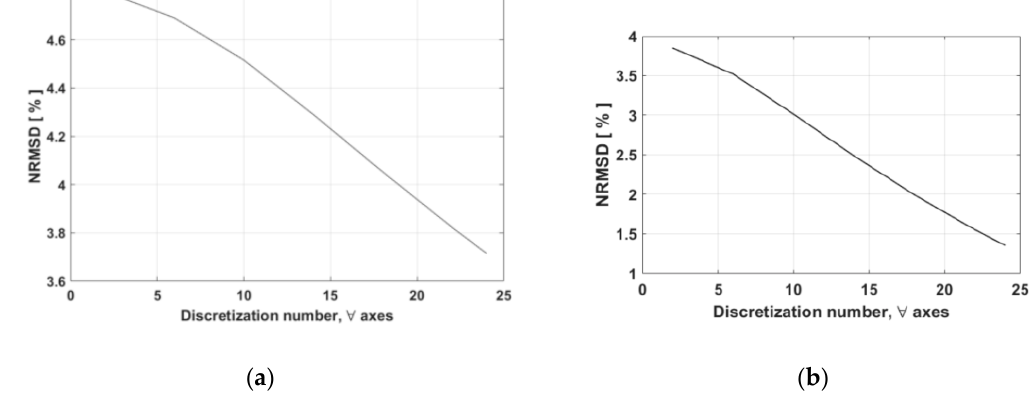
Figure 18. NRMSD according to the discretization number in both axes (i.e., x- and y-axis) for: ( a ) h mp = 6mm and ( b ) h mp = 10 mm .